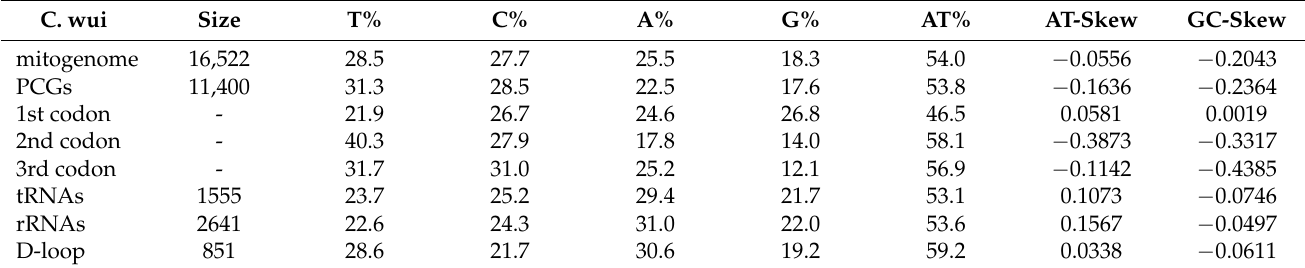
Table 3. General metrics of nucleotide composition of C. wui .